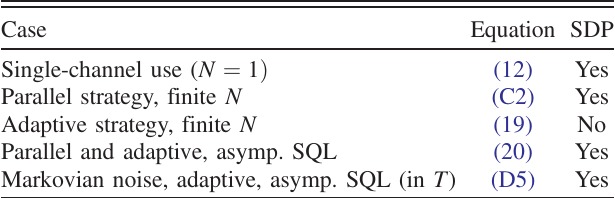
TABLE I. Summary of the bounds on the total QFI obtained in this paper. The SDPs can be found in Appendix